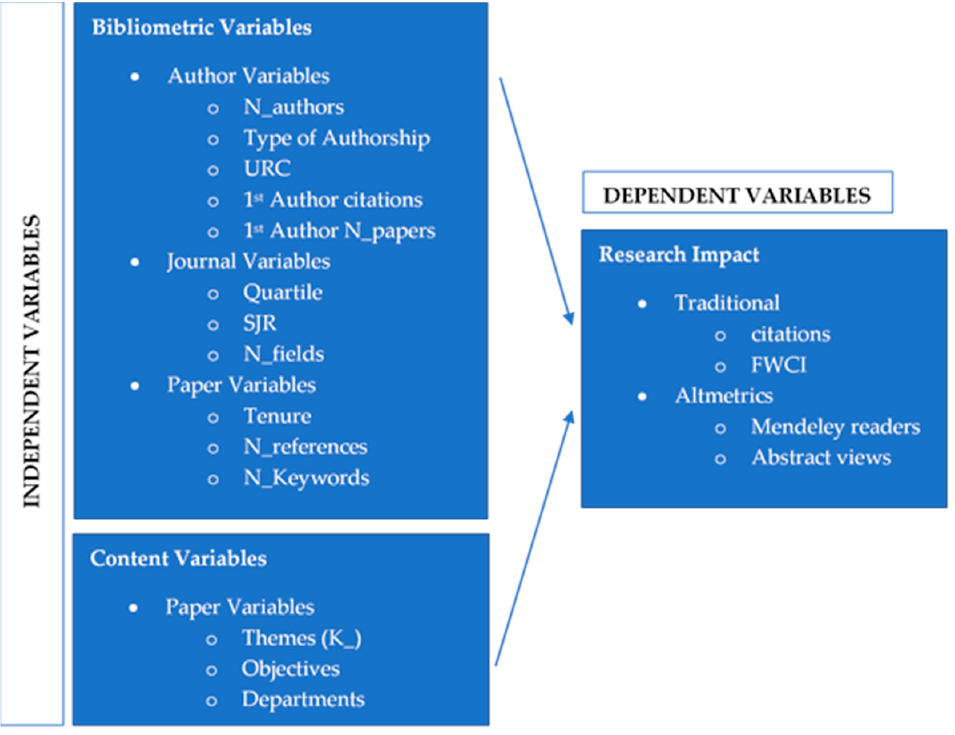
Figure 2. Graphic model of variables analyzed.